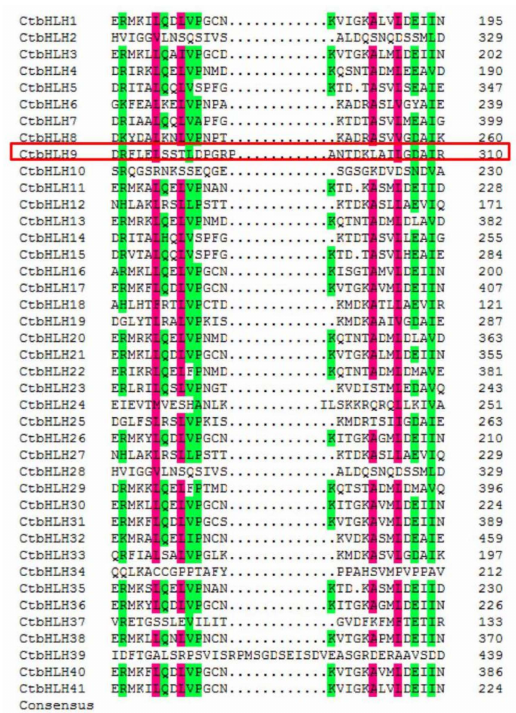
Figure 3. Conserved amino acid residues and pairwise alignment of the sa ffl ower bHLH proteins. The colored boxes indicate 50% identity of amino